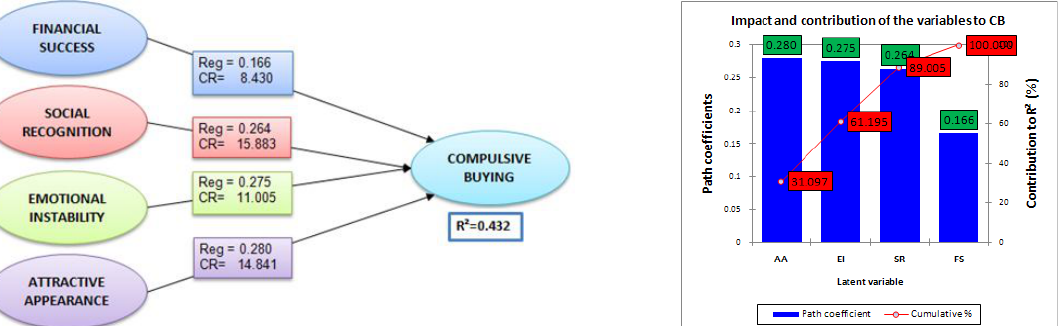
Fig. 2. The results of structural equation modeling as well as standard